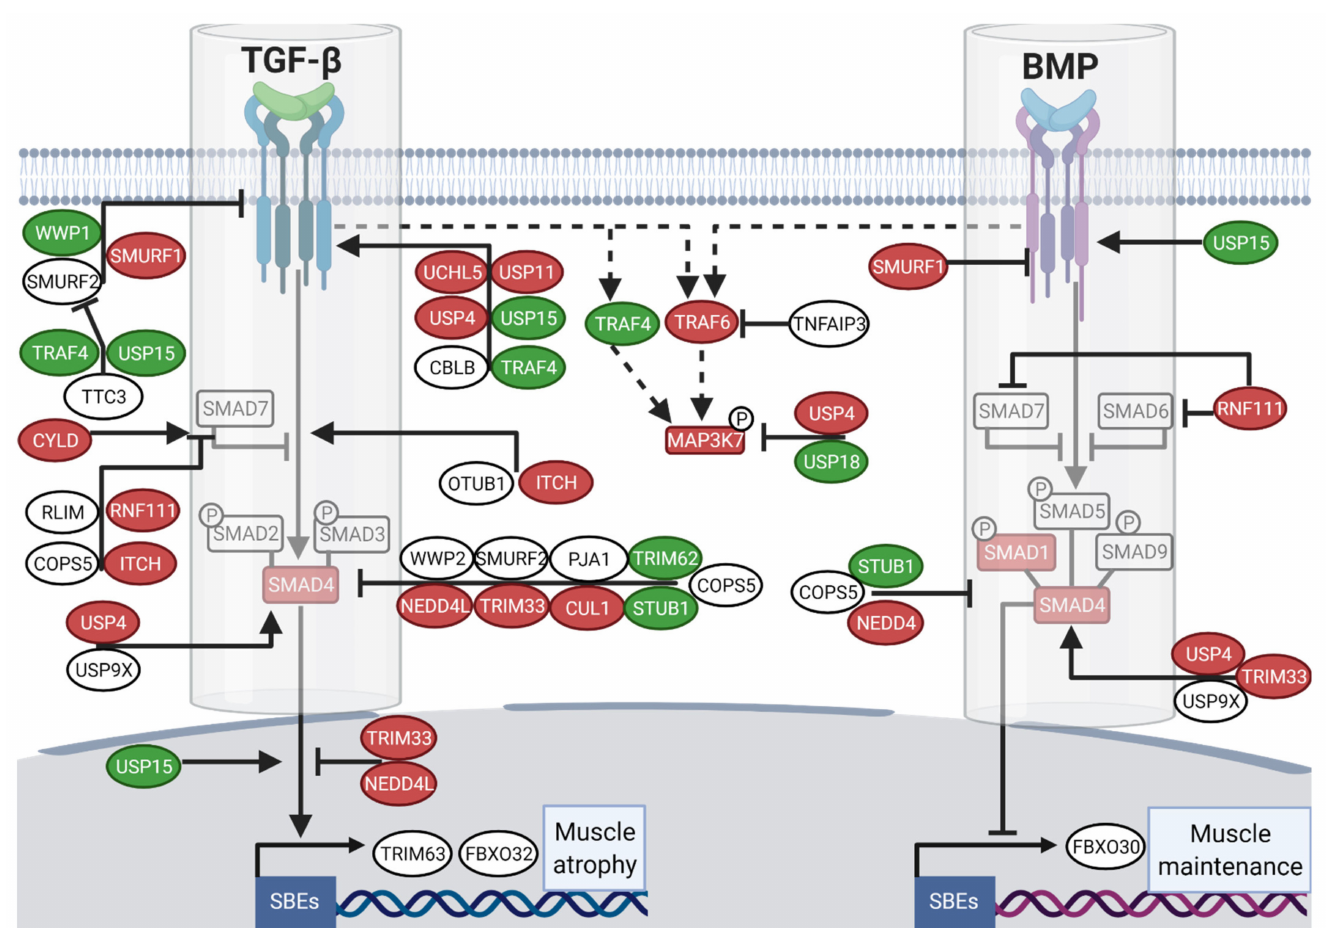
Figure 3. A transcriptomic reprogramming of UPS components involved in TGF- β and BMP regulation prevails in muscle during brown bear hibernation. Scheme showing the E3s/DUBs enzymes regulation of brown bear vastus lateralis muscle transcripts involved in TGF- β and BMP signaling pathways and depicting (i) their relationships [12,60] and (ii) the difference in their expression levels between hibernation and activity periods. Red and green boxes indicate, respectively up- down- regulated genes during hibernation compared to the summer season, and white boxes indicate unchanged genes. Dashed lines show the SMAD-independent pathway and full lines the canonical signaling. Arrows indicate activation and bars inhibition. ( n = 6 bears/season, the same individuals were sampled and analyzed in summer and winter, padj < |0.05|; Table S4). SBEs: SMAD Binding Elements. Created with